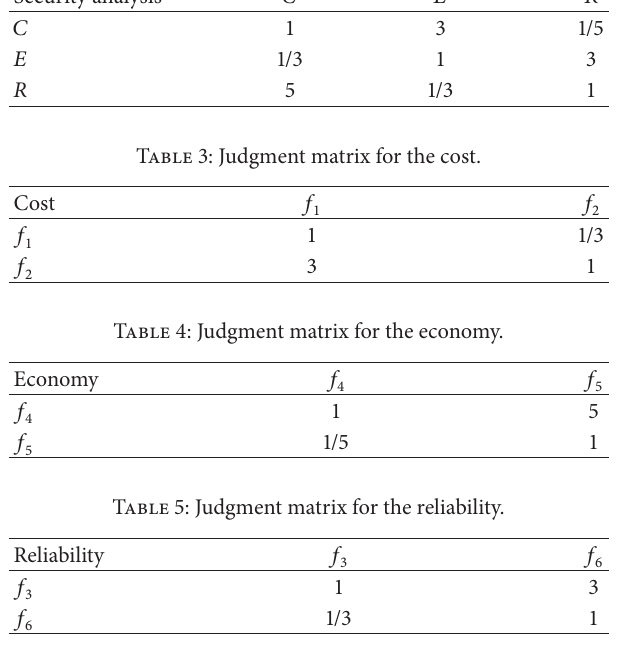
Table 6: Weight for the security